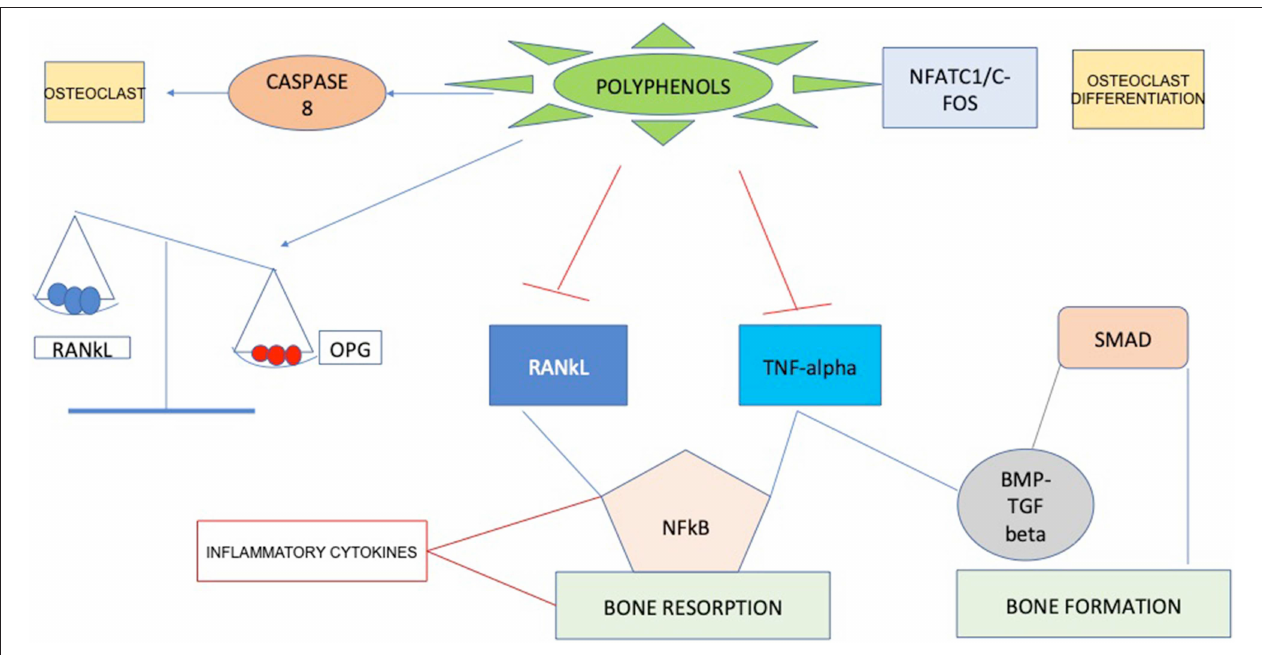
FIGURE 1 | Schematic pathway illustrating the action of polyphenols on bone